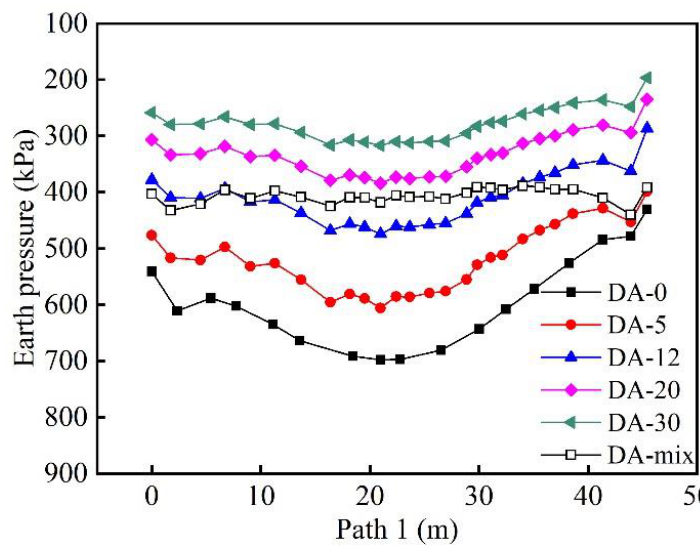
Figure 10. Curve of earth pressure along path 1 .